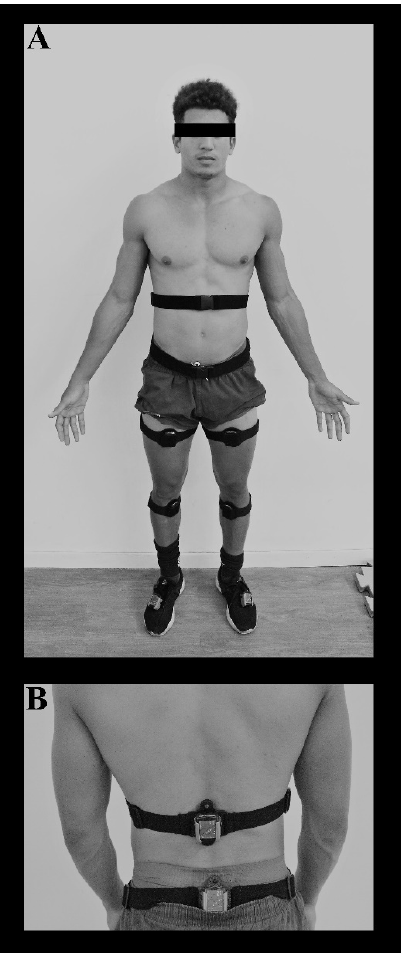
Figure 4. Inertial sensor placement: ( A ) front view; ( B ) back view.